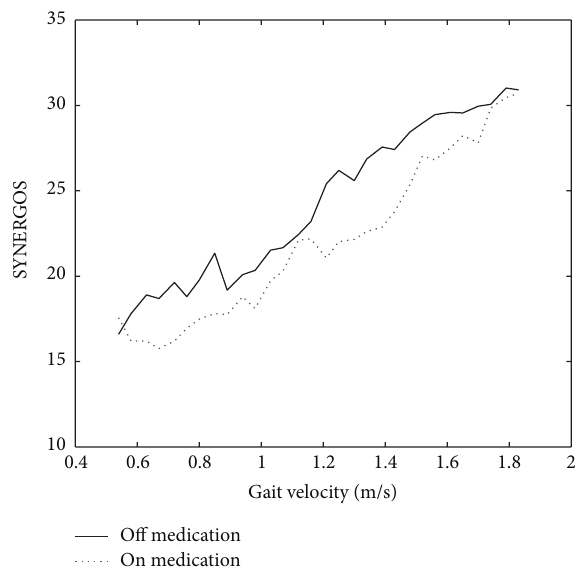
Figure 5: The mean values of the SYNERGOS indices were com- pared while on and off medication, during which lower MMA is associated with medication